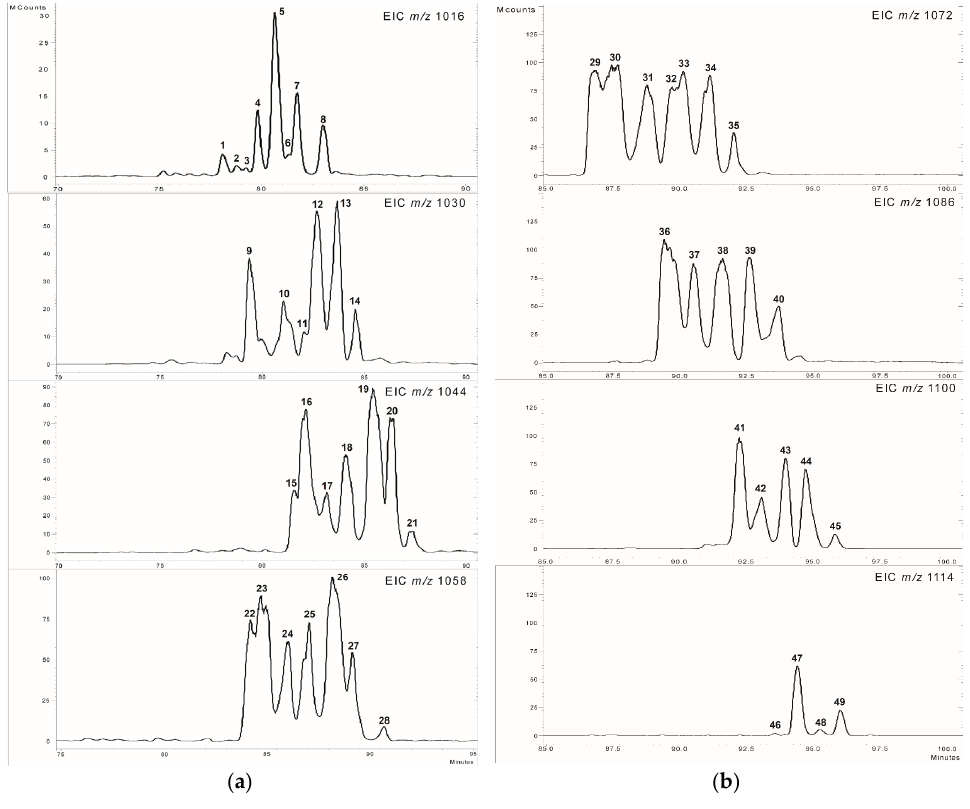
Figure 2. The extracted ion chromatograms of m / z 1016–1058 ( a ) and m / z 1072–1114 ( b ).